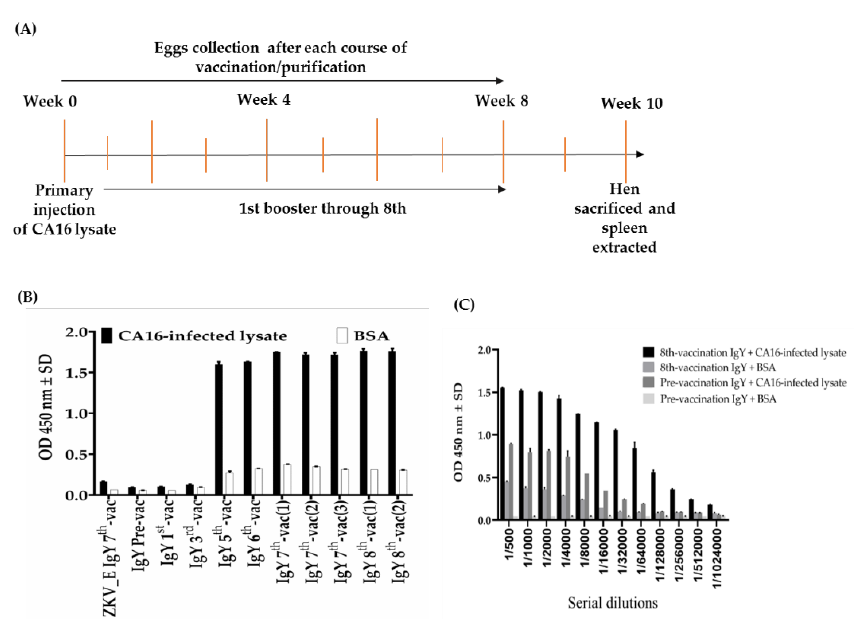
Figure 1. Immune response analysis before each immunization. ( A ) Simplified diagram of vaccination protocol with primary injection, then first booster through booster number 8. ( B ) The binding ability of purified immunoglobulin yolk (IgY)-binding protein antibodies against CA16-infected lysate and bovine serum albumin (BSA). The abbreviations pre- or 8th-vac, etc., represent pre-vaccination through to the eighth vaccination on a weekly basis. The numbers 1, 2, or 3 mean the number of eggs IgY purified at that vaccination. The ELISA assay was run to confirm the immune response induction in the laying hen. Zika virus envelope (ZKV_E) IgY 7th-vac was used as a negative antibody control. ( C ) An ELISA test was conducted to reveal the total IgY antibody at dilutions of 1/500 to 1/1,024,000. The assay compared the pre-vaccination IgY titer to the 8th-vaccination IgY titer. The experiments were run in duplicate and data presented as average ± standard deviation (SD).